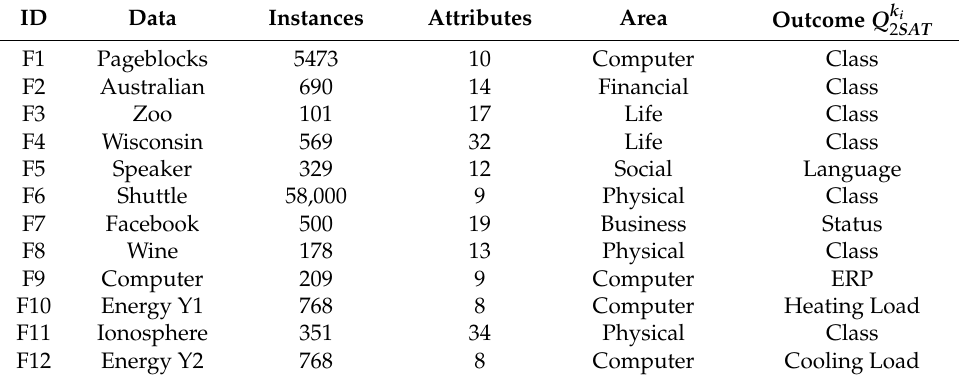
Table 1. List of